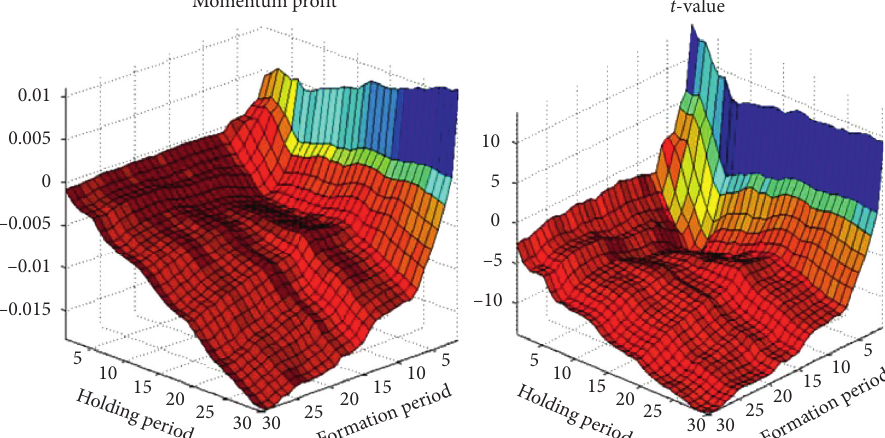
Figure 4: Lowest daily relative order imbalance in extensions of the A-share market. This figure plots the daily momentum profits and their t -statistics under the lowest daily relative order imbalance in A-share market. The formation and holding periods, respectively, range from 1 day to 30